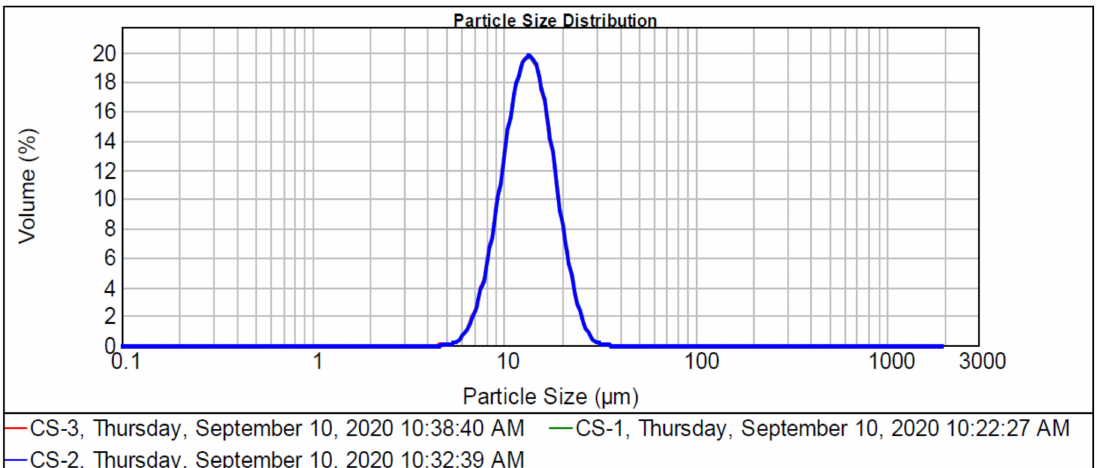
Figure 3. Particle size distribution (PSD) of corn